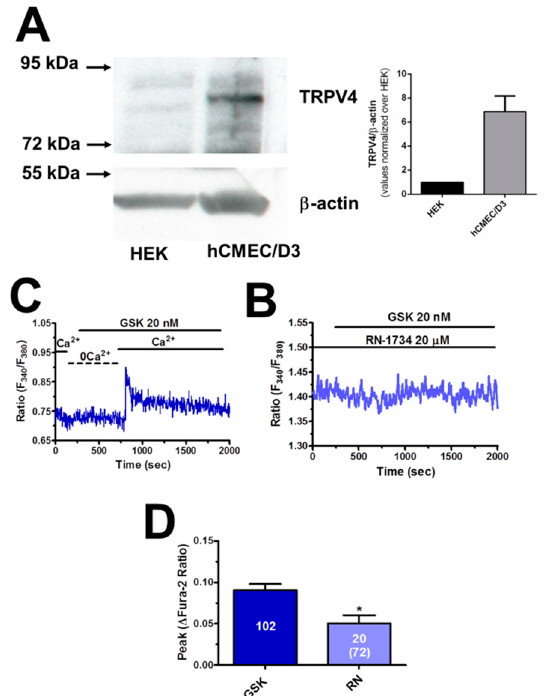
Figure 5. Transient Receptor Potential Vanilloid 4 (TRPV4) protein is expressed and mediates extracellular Ca 2 + influx in hCMEC / D3 cells. ( A ) Left, representative Western blots illustrating TRPV4 and β -actin expression in HEK-293 cells (HEK) and hCMEC / D3 cells. Left, quantification of TRPV4 / β -actin protein levels in hCMEC / D3 cells normalized on HEK cells from three independent experiments. ( B ) GSK1016790A (GSK; 20 nM) increased the [Ca 2 + ] i in the presence, but not in the absence (0Ca 2 + ), of extracellular Ca 2 + . ( C ) RN-1734 (20 µ M, 20 min) blocked GSK-evoked extracellular Ca 2 + influx. GSK was administered at 20 nM. ( D ) Mean ± SE of the amplitude of GSK-induced Ca 2 + influx in the absence and in the presence of RN-1734 (RN). The total number of cells analysed in the presence of RN is indicated in the brackets. The asterisk indicates p < 0.05.